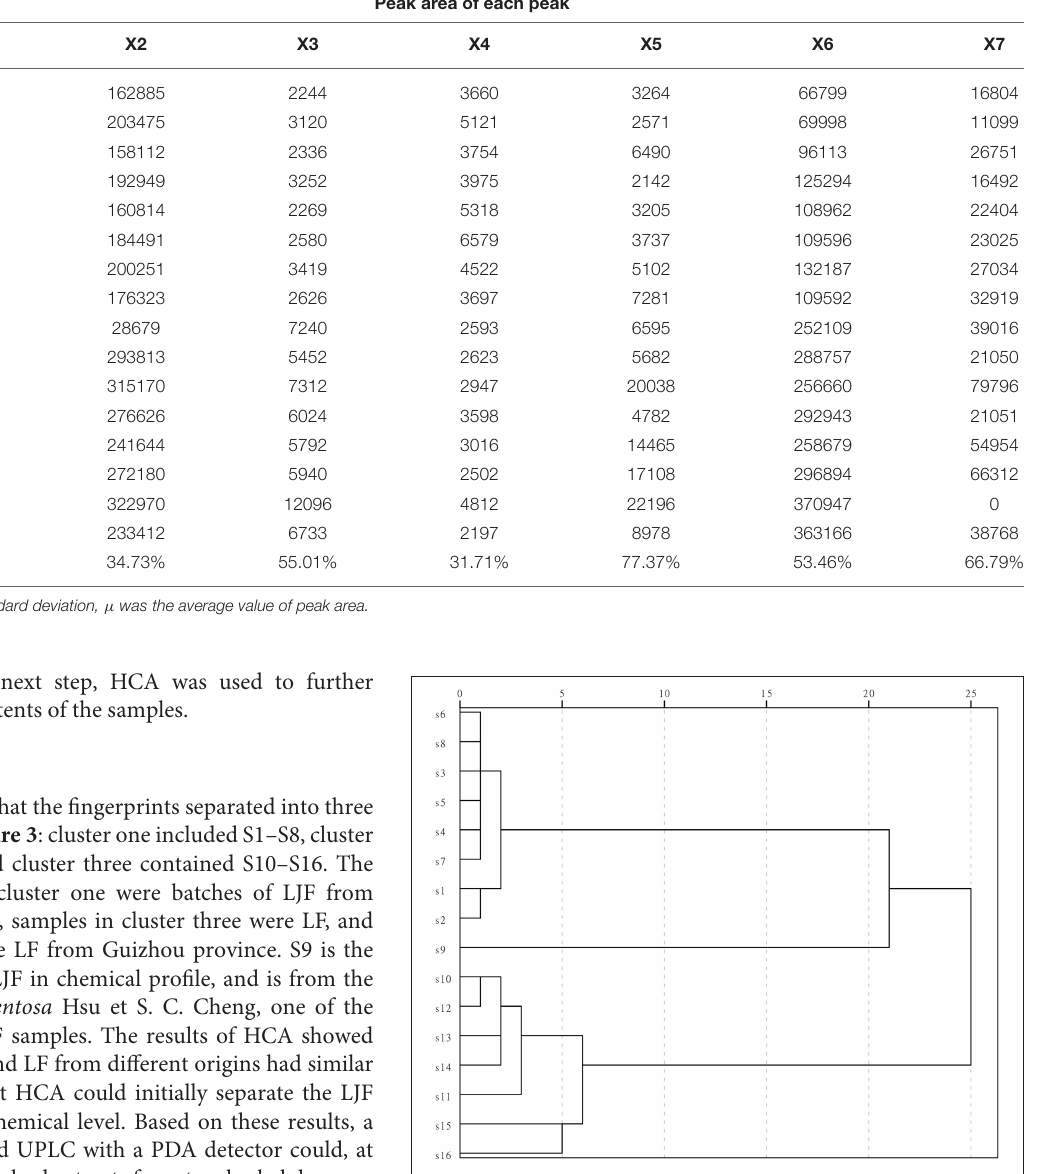
TABLE 1 | Peak areas of seven common peaks identified in UPLC results from bud samples. Sample